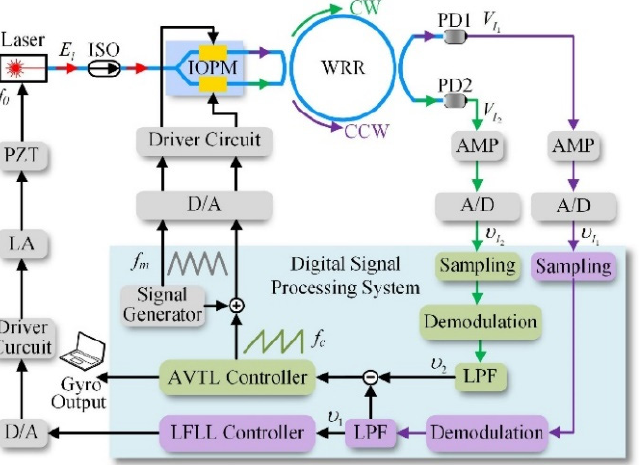
Figure 18. The signal detection scheme of the RIOG system. IOPM: integrated optical phase modulator; LA: linear amplifier; PZT: piezoelectric transducer; LFLL: laser frequency lock loop; AVTL: angular velocity tracking loop. f m is the frequency of triangular modulation, and f c is the frequency of the feedback sawtooth wave. Reprinted with permission from ref. [89]. Copyright 2021